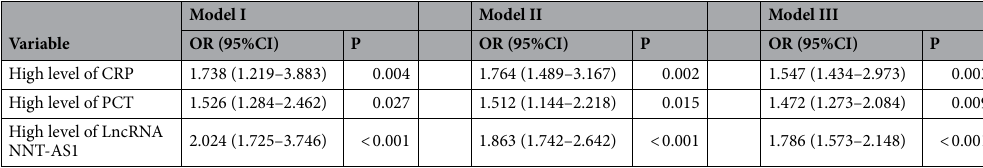
Low level of NNT-